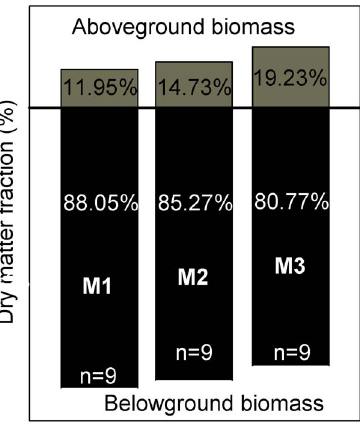
Figure 4. Biomass fractions (% of total biomass) in herbaceous plants in M1, M2 and M3 of Tibetan